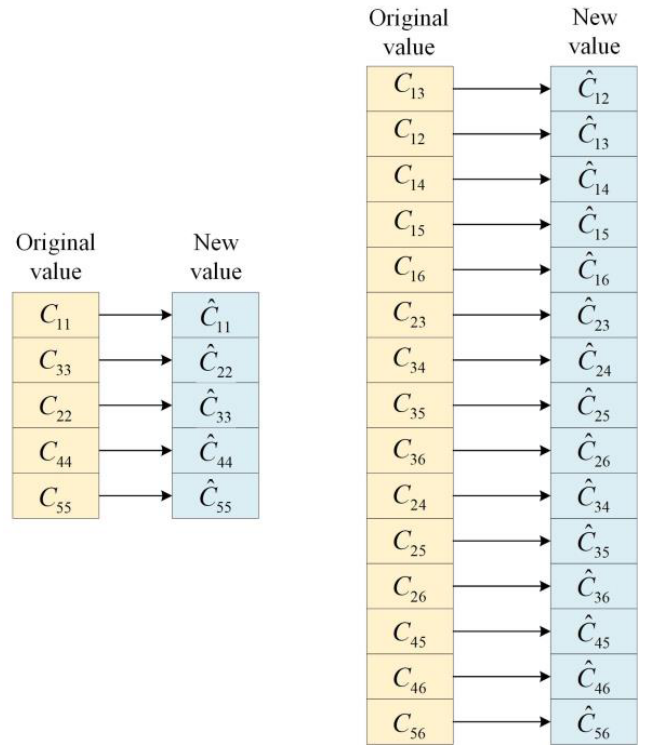
Figure 6. The transformation rule between the original data and the new data.